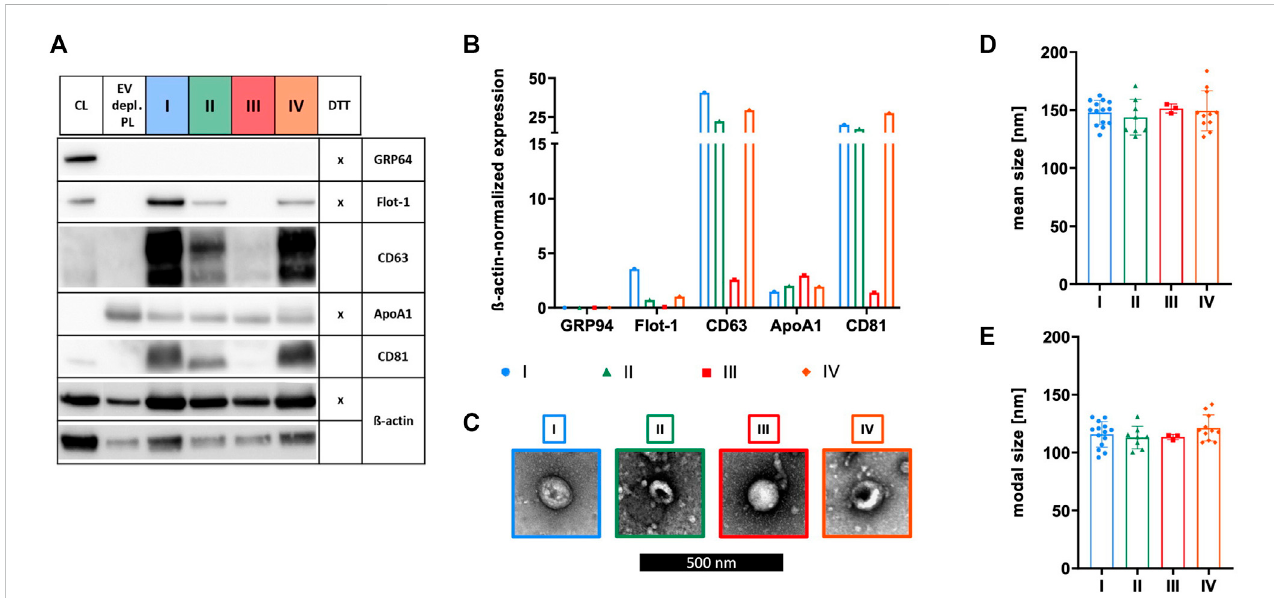
FIGURE 3 Characterization of sEVs. After isolation by methods I (blue), II (green), III (red), and IV (orange), sEVs were characterized. (A) Western blotting was performed in order to investigate the expression of proteins GRP94, Flot-1, CD63, ApoA1, and CD81. MSC cell lysate (CL) and EV depl. PL served as controls for primary antibodies, and ß-actin was used as loading control. Reducing conditions for indicated proteins were obtained by the addition of dithiothreitol (DTT). (B) Chemiluminescent signal intensities were quanti fi ed and normalized on ß-actin intensities, resulting in ß-actin-normalized expression of proteins. (C) sEVs were visualized by negative contrast staining using TEM with 60,000 times magni fi cation. The black scale bar represents 500 nm. (D) + (E) Mean and modal size of sEVs was determined by NTA. Representative images are depicted for western blotting and TEM. Data are presented as mean ± SD, and N ≥ 3 independent experiments were performed for NTA